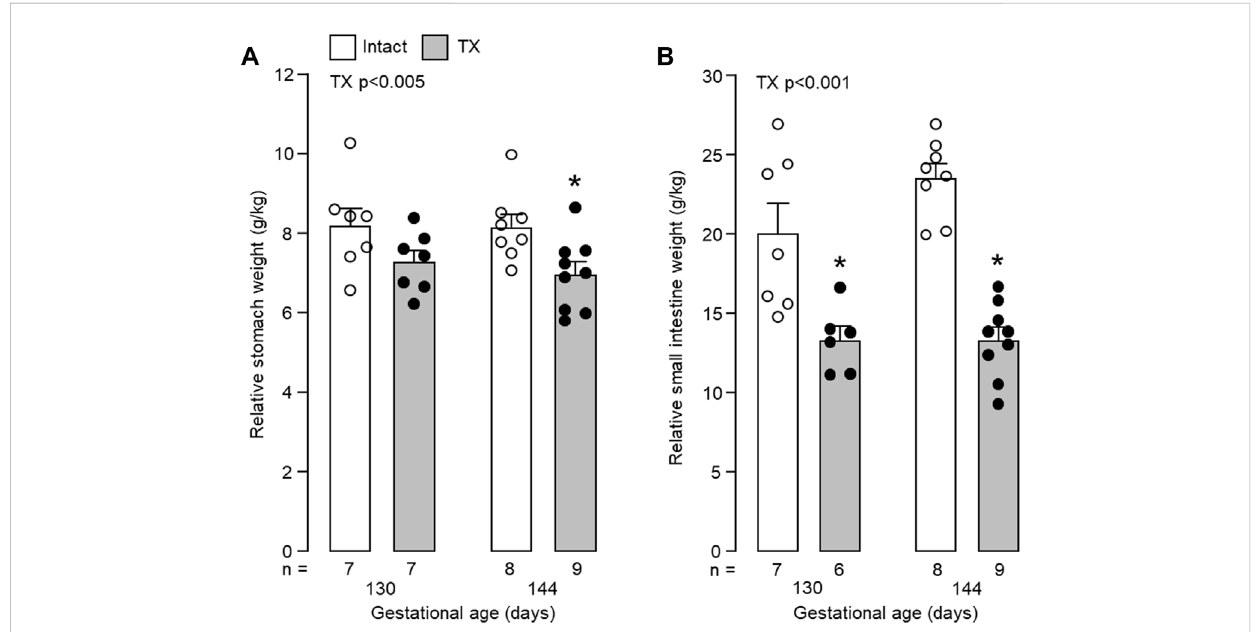
FIGURE 4 Mean (±SEM) and individual weights of (A) the empty stomach and (B) the small intestines, expressed relative to body weight, in the fetuses of each experimental group. *, signi fi cant difference from intact fetuses at the same gestational age ( p < 0.05, Tukey ’ s post hoc test following two-way ANOVA). Numbers of fetuses in each group are indicated at the base of the histogram. TX,